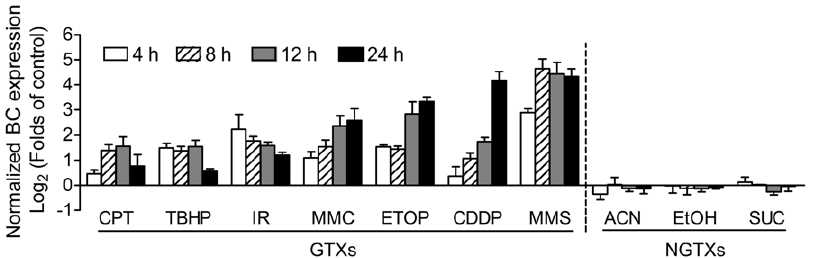
Figure 3. Expression of BC was specifically induced by GTXs in NIH/3T3 cells. Data from quantitative PCR showing transcriptional expression of BC in NIH/3T3 cells treated with genotoxic or non-genotoxic chemicals for indicated time. Data were mean 6 s.d. of three independent experiments.